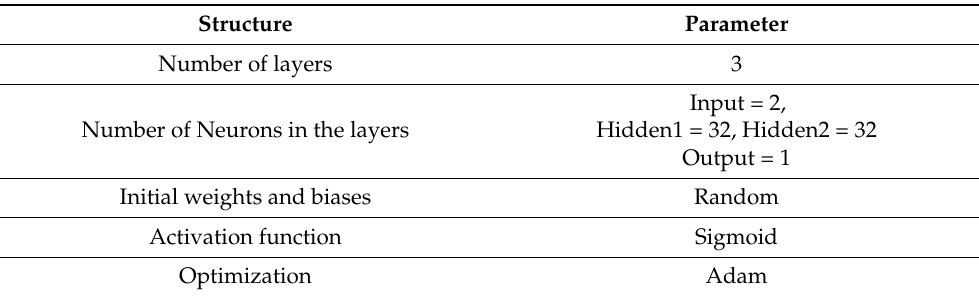
Table 1. MLP network structure parameter